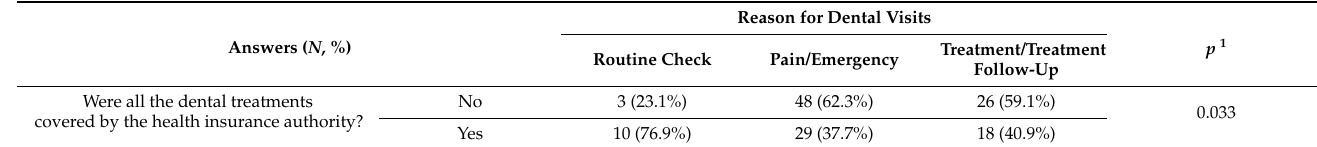
Table 8. Distribution of the participants according to reason for dentist visit and certain answers in the survey.